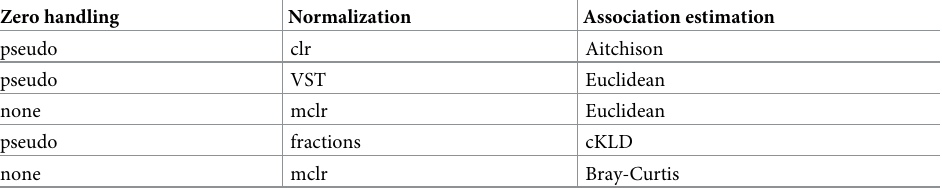
Table 7. Method combinations for dissimilarity calculation. The dissimilarity matrices were used as input for PAM and spectral clustering. Zero